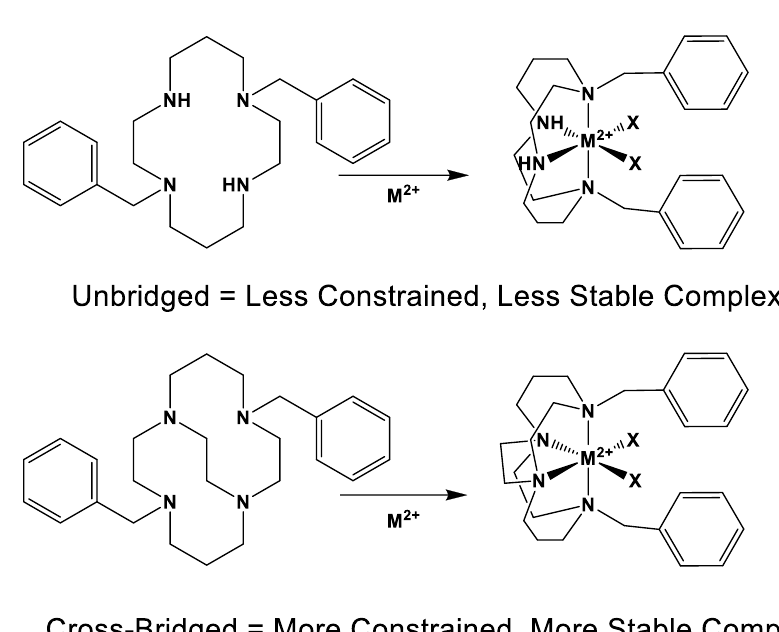
Figure 1. Unbridged vs. cross-bridged tetraazamacrocycles and